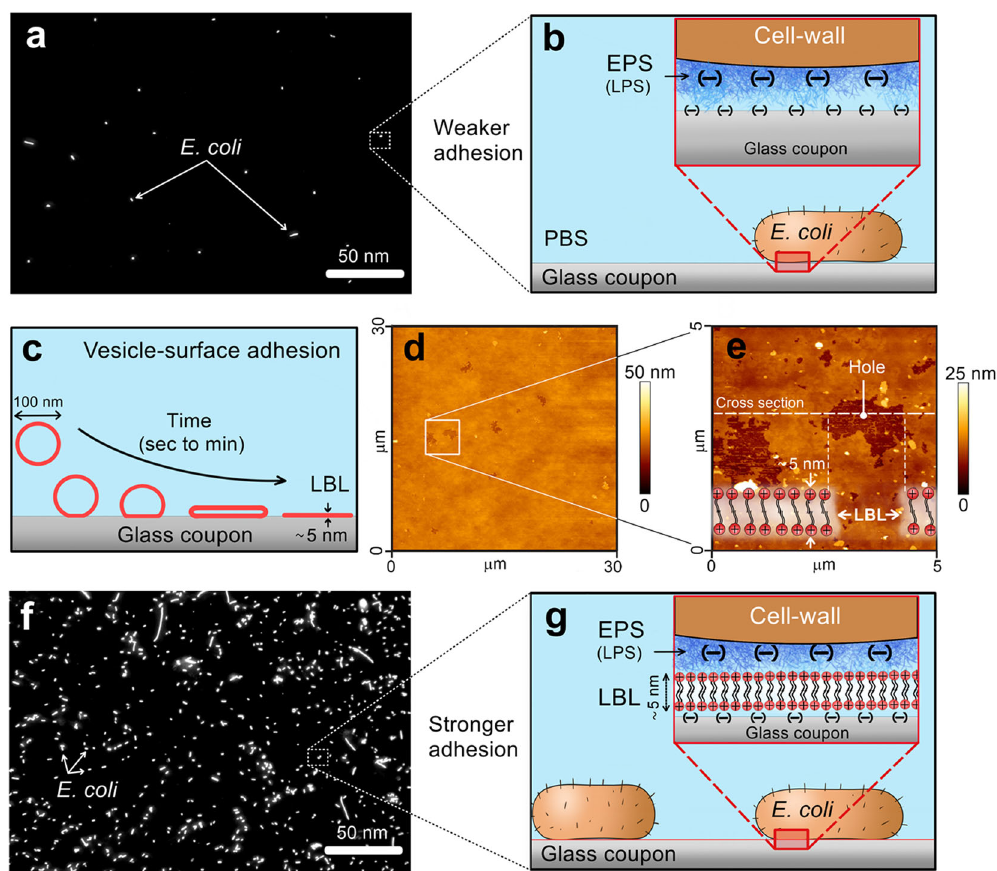
Fig. 1 The procedure used for E. coli attachment to AFM coupons. Cells were attached to an AFM glass coupon via a positively charged lipid bilayer (LBL), which served as a rigid and adhesive support. a Fluorescence micrograph of a sparse E. coli cell coverage on a glass coupon without LBL coating. b Schematic illustration of the molecular interactions between E. coli cells and the glass coupon, pointing on repulsive electrostatic interactions together with weak van der Waals adhesion between the extracellular polysaccharide substances (EPS) and the surface. c LBL was prepared on an AFM glass coupon using vesicle fusion techniques, where lipid vesicles adhere to the surface, rupture, and form an LBL coating. d , e AFM images (in physiological solution) of positively charged LBL on an AFM glass coupon with a corresponding illustration of the LBL coating. Holes in the LBL allowed us to measure the layer thickness. f Fluorescence images of E. coli cells attached to a glass coupon that was precoated by a positively charged LBL. g Schematic illustrations that exhibit the electrostatic adhesion that attaches E. coli cells to the positively charged coated